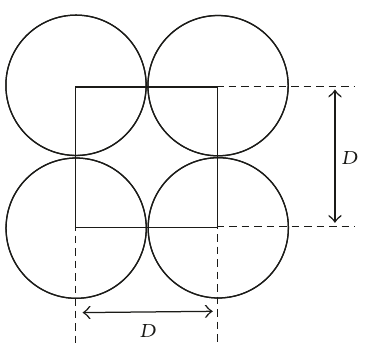
Figure 5: Schematic diagram of stress unit in the same layer.